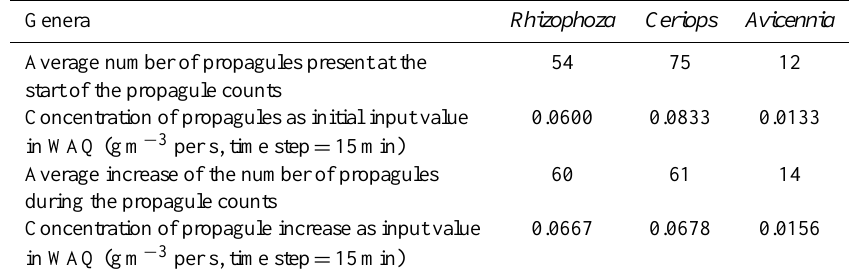
Table 2. Input values of propagule “concentrations” in Delft3D-WAQ based on the successive propagule counts. Given the nature of the advection-diffusion model, the input requires the numbers of propagules to be converted into concentrations (gm − 3